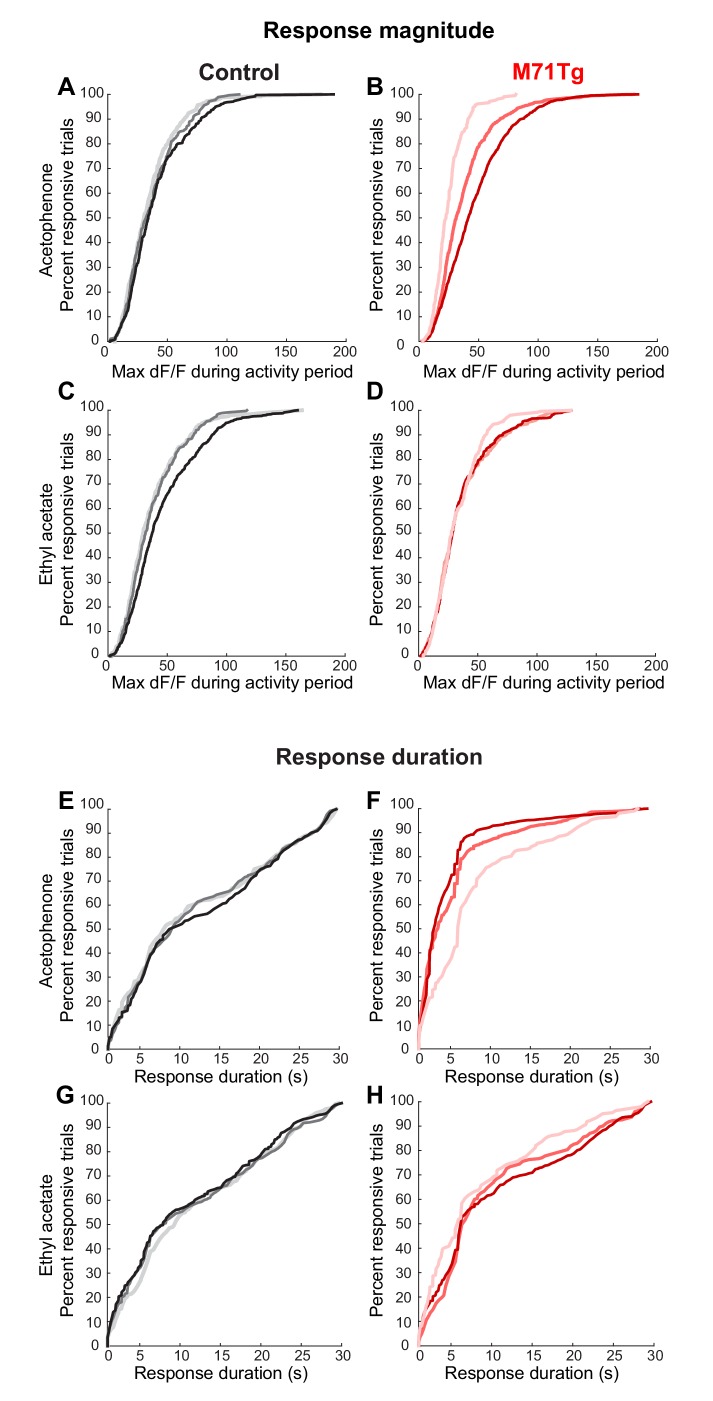
Response magnitudes and durations strongly increase with increasing acetophenone concentrations in M71 transgenic mice.(A–H) Two-photon in vivo imaging of mitral cell odor responses in anesthetized mice. (A, B) Cumulative frequency plot of the peak DF/F values for mitral responses in control (A) and M71 transgenic (B) mice to increasing acetophenone concentrations. Light, intermediate and dark colored curves represent responses to low (1:10.000 vol./vol.), intermediate (1:1.000 vol./vol.) and high (1:100 vol./vol.) odorant concentration. (C, D) Cumulative frequency plot of the peak DF/F values for mitral responses in control (C) and M71 transgenic (D) mice to increasing ethyl acetate concentrations. (E, F) Cumulative frequency plot of response durations of mitral cells in control (E) and M71 transgenic (F) mice to increasing acetophenone concentrations. (G, H) Cumulative frequency plot of response durations of mitral cells in control (G) and M71 transgenic (H) mice to increasing ethyl acetate concentrations.